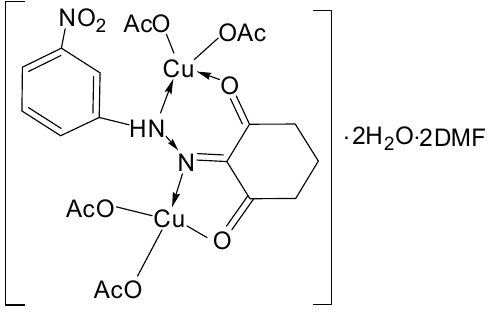
Figure 6. Structure of [Cu 2 (L 2 )(OAc) 4 ]·2H 2 O·2DMF complex.